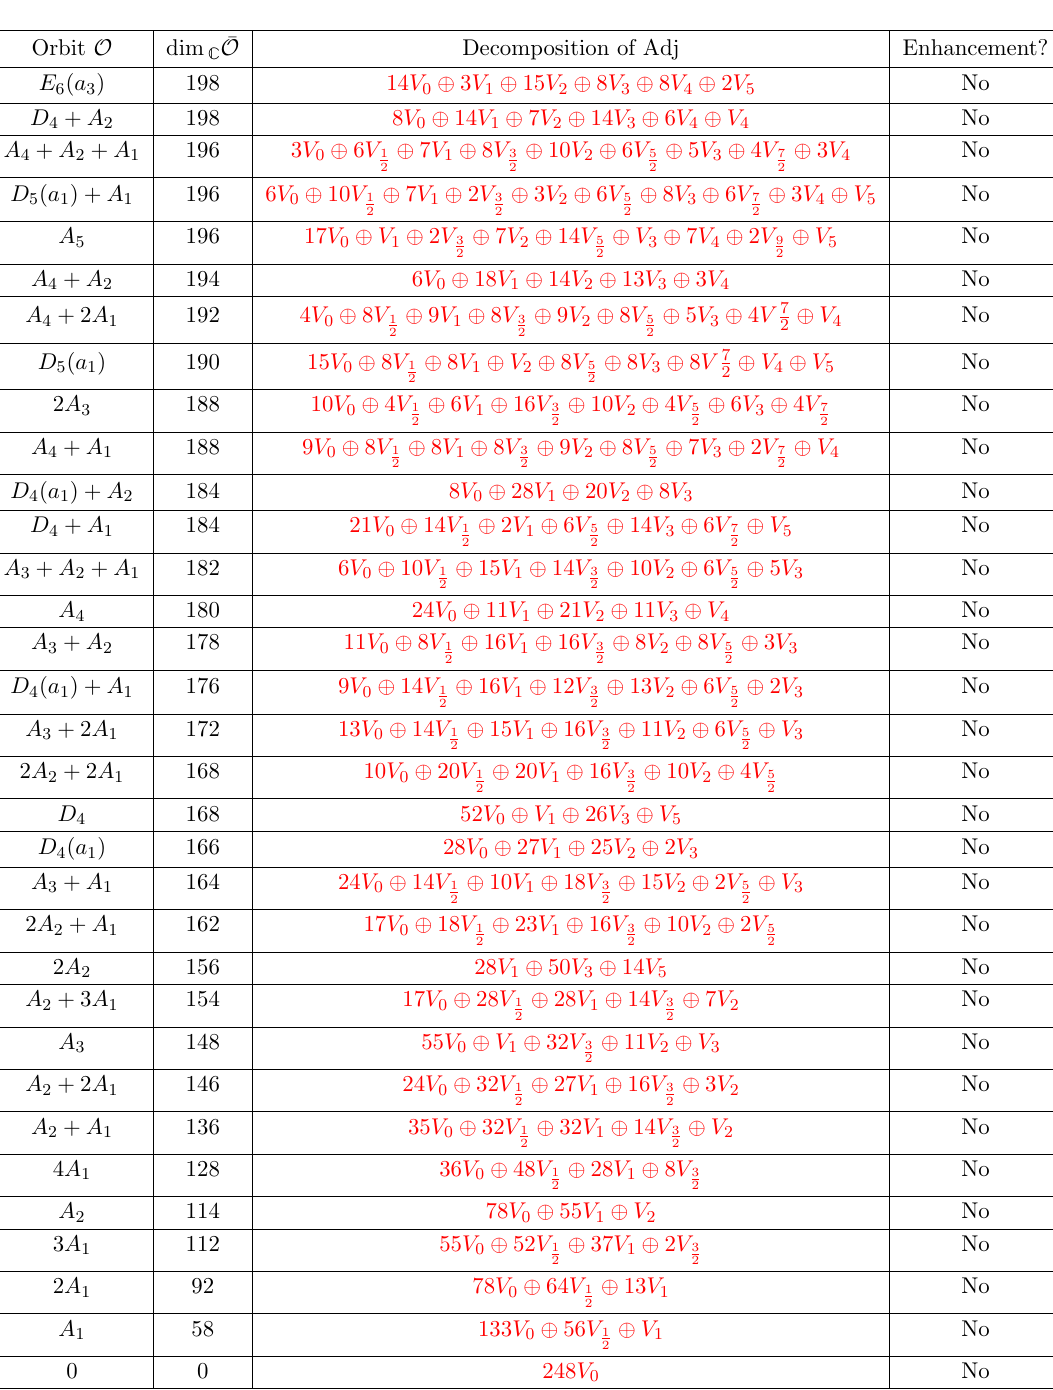
Table 6 . All the orbits or e 8 and their adjoint decomposition. Part 2. Table taken from [56].